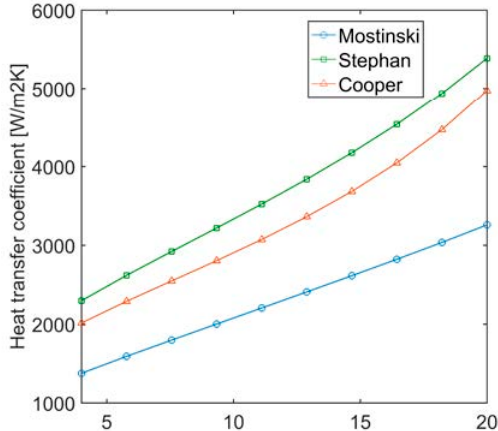
Figure 4. Comparison of heat transfer correlations for pool nucleate boiling.